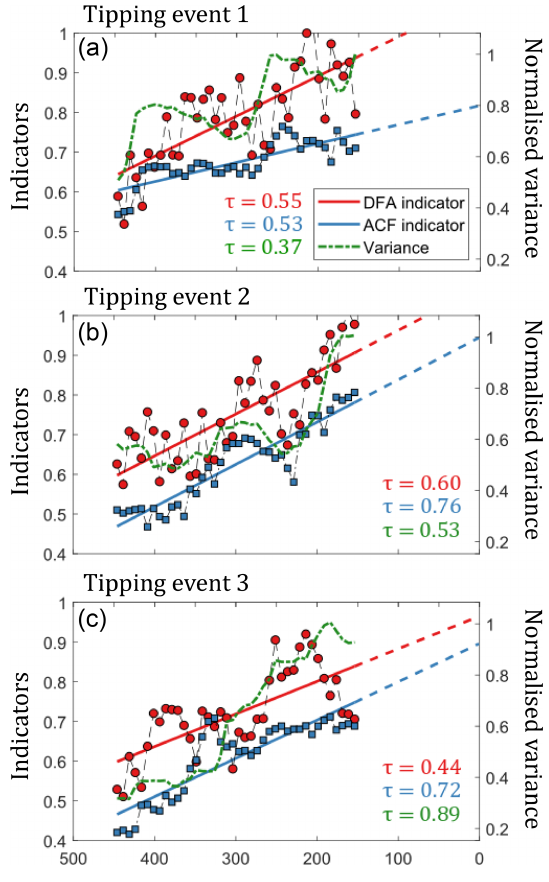
Figure 5. EWIs for the marine ice sheet instability in Pine Island Glacier. Each panel shows the EWIs preceding each of the three MISI tipping-point events marked in Fig. 3b, along with the linear trend extrapolated to the point in the simulation when the respective tipping event occurs. Increasing trends in all indicators are shown by a positive Kendall’s τ coefficient which measures the correlation between each indicator and time at between − 1 and 1.